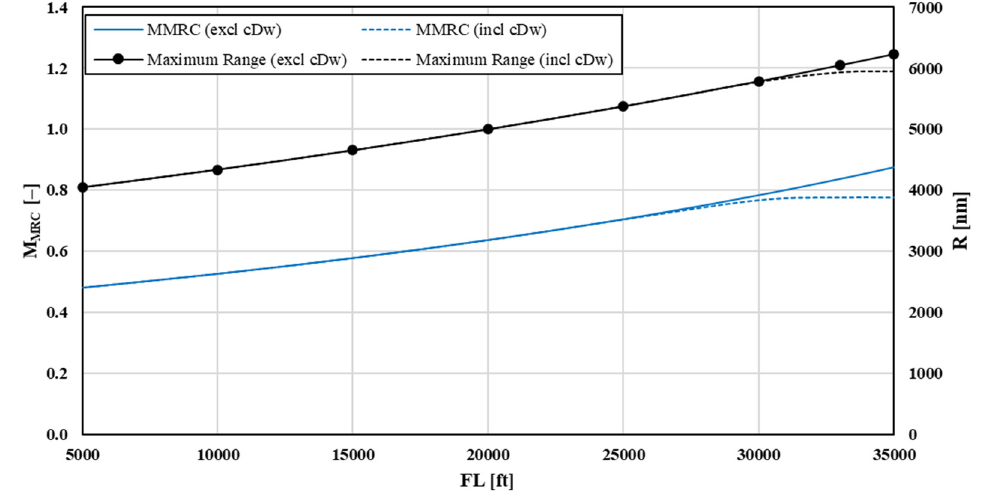
Figure 5. M MRC and range for different FLs for both models, with/without wave drag.